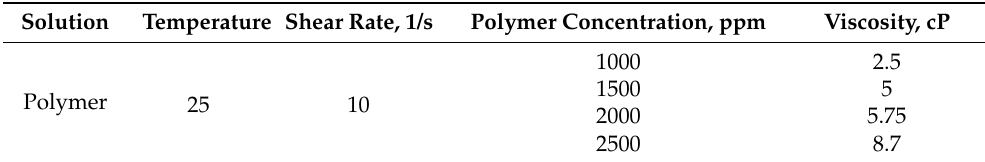
Figure 5. Comparison of pure polymer and nanofluid-polymer rheology ( a ) 1000 ppm ( b ) 1500 ppm ( c ) 2000 ppm and ( d ) 2500 ppm. Table 8. Rheology of pure polymer